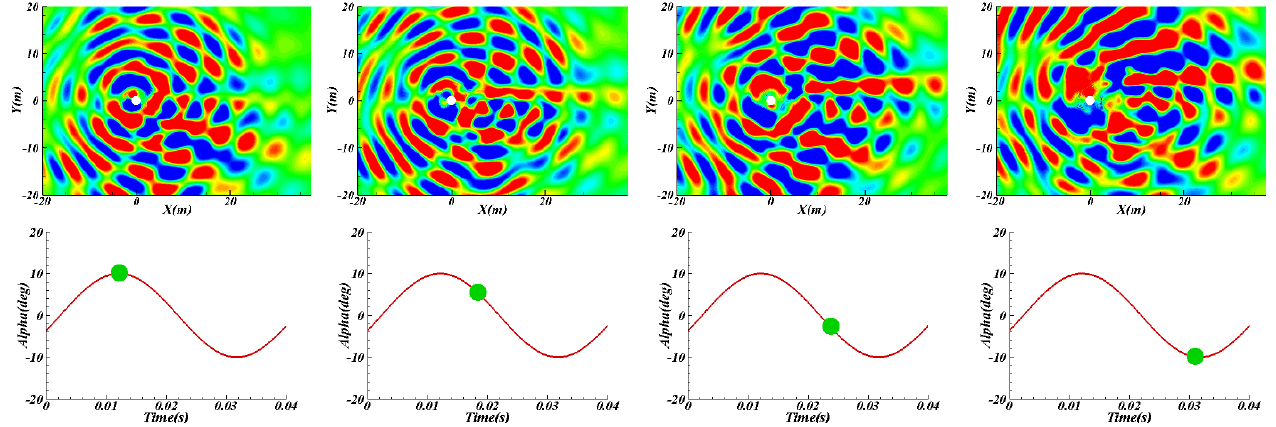
Figure 15. The sound wave distribution in a rotating oscillation period (Case2). The green dots represent different moments in a cycle time.